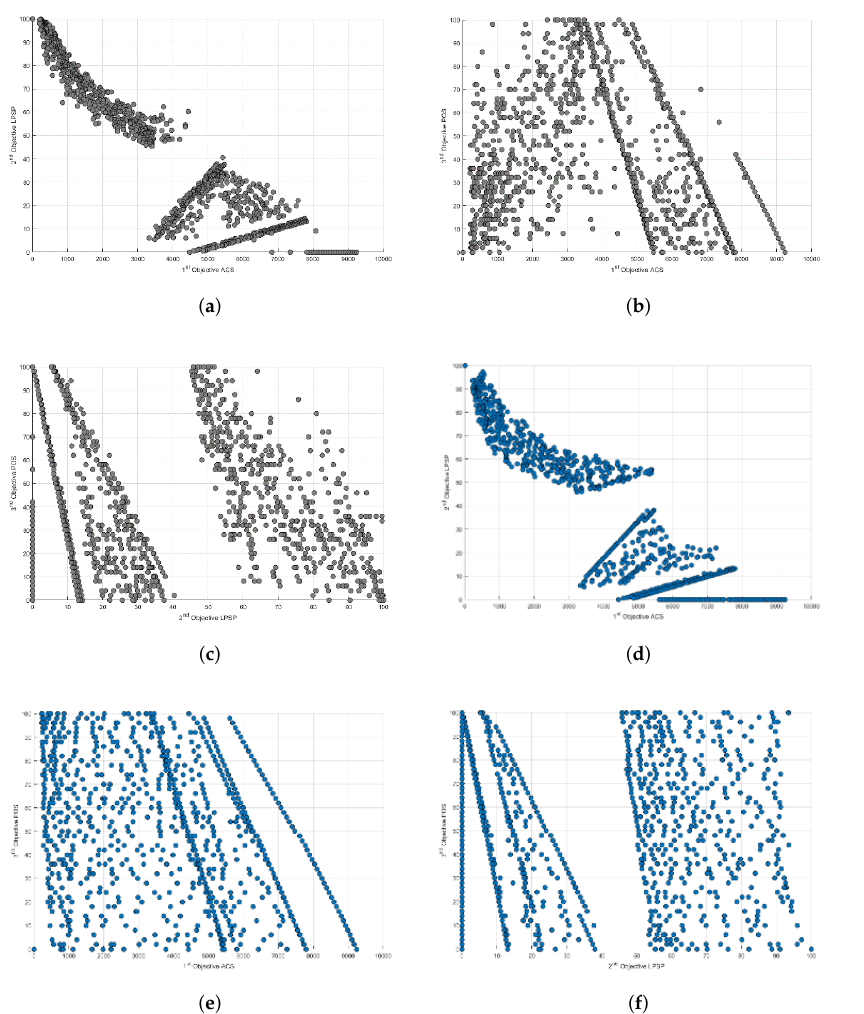
Figure 12. Contrast of 2D PF projections. ( a ) PF obtained by the PUSS method projected onto the X-Y(ACS-LPSP) plane. ( b ) PF obtained by the PUSS projected onto the X-Z(ACS-POS) plane. ( c ) PF obtained by the PUSS method projected onto the and Y-Z (LPSP-POS) planes. ( d ) PF obtained by the compared method projected onto the X-Y(ACS-LPSP) plane. ( e ) PF obtained by the compared projected onto the X-Z(ACS-POS) plane. ( f ) PF obtained by the compared method projected onto the and Y-Z (LPSP-POS)